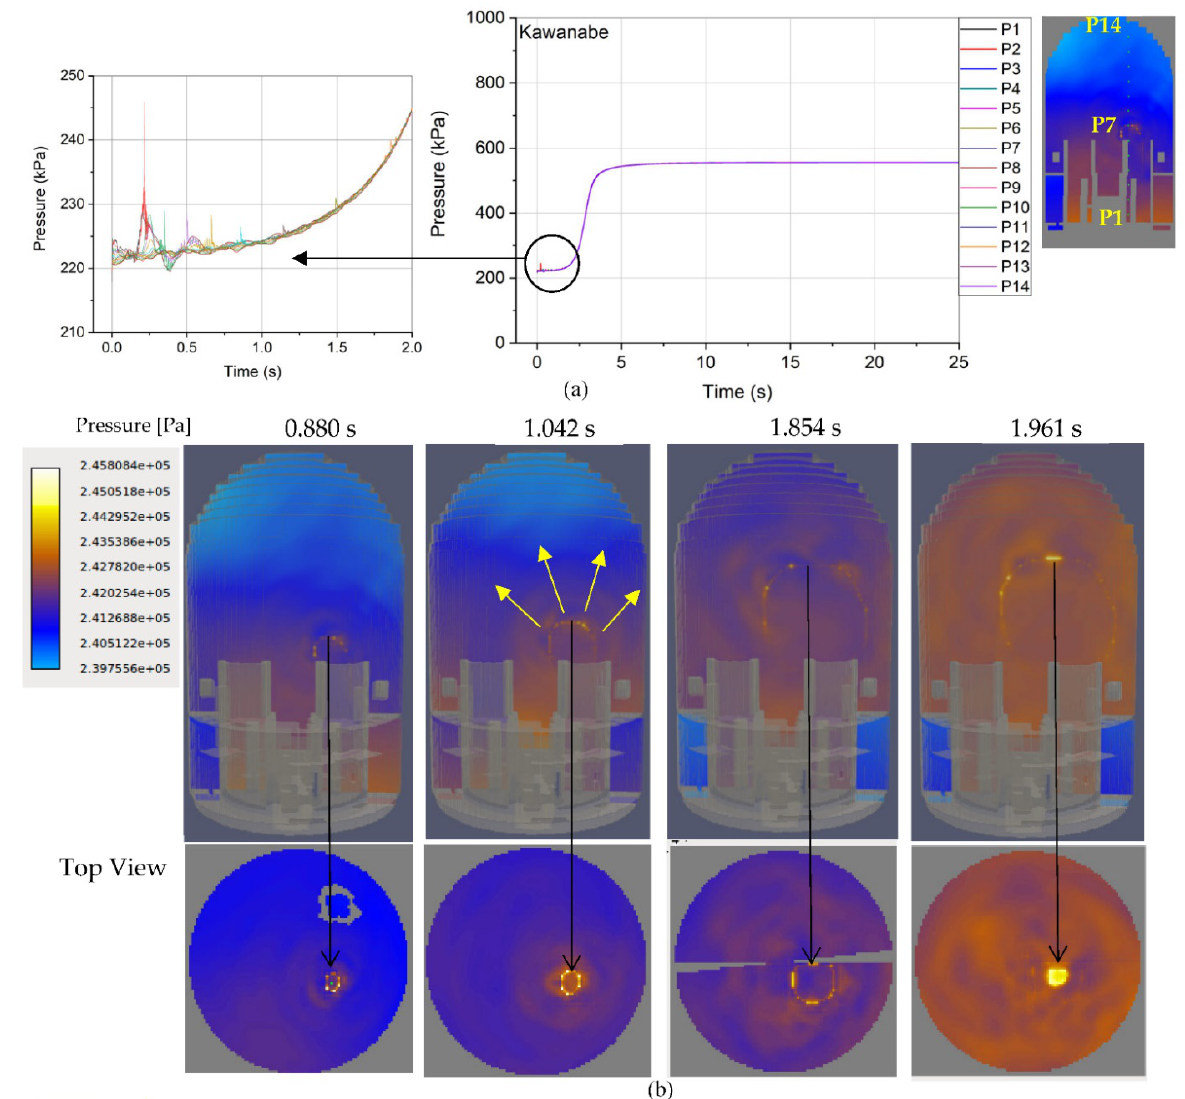
Figure 10. Calculated pressure results. ( a ) Pressure behaviors at P1 to P14. ( b ) Pressure distribution to time variation.